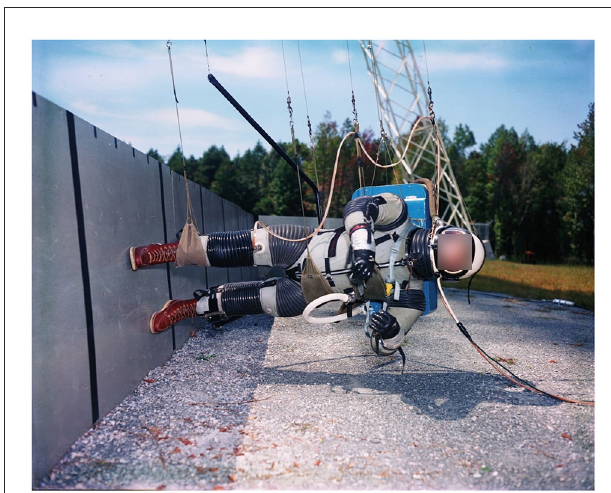
FIGURE1 “Lunar Landing Walking Simulator” at NASA Langley Research Center (1965): Enabling researchers to study the ability to walk, run and perform other tasks required during Lunar exploration. Photo courtesy of